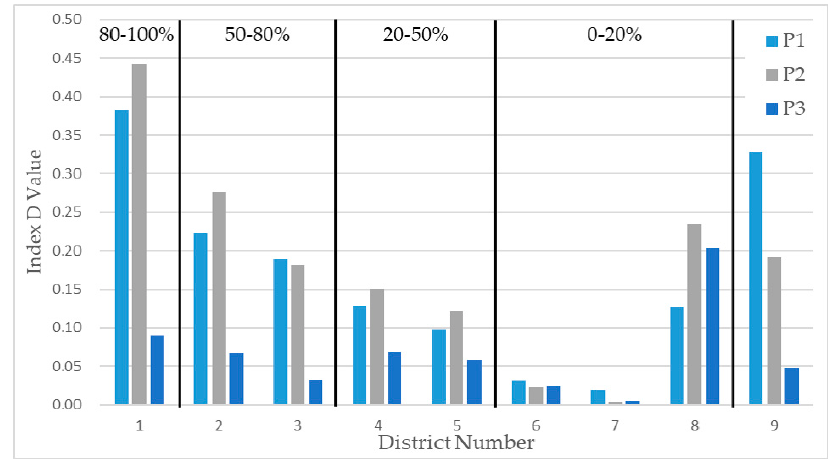
Figure 11. The mean values of the index D values in each selected district from P1, P2, and P3. The damage level is annotated in the graph. The locations of the nine districts are labeled in Figure 6.